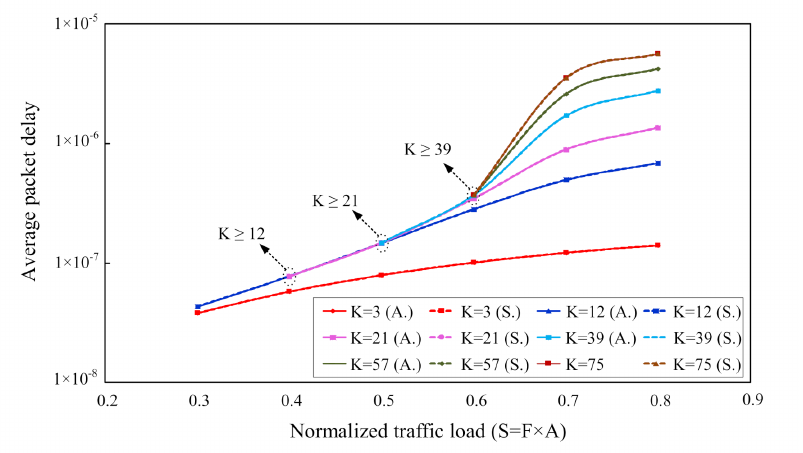
Figure 6. Average packet delay versus the normalized incoming traffic load per